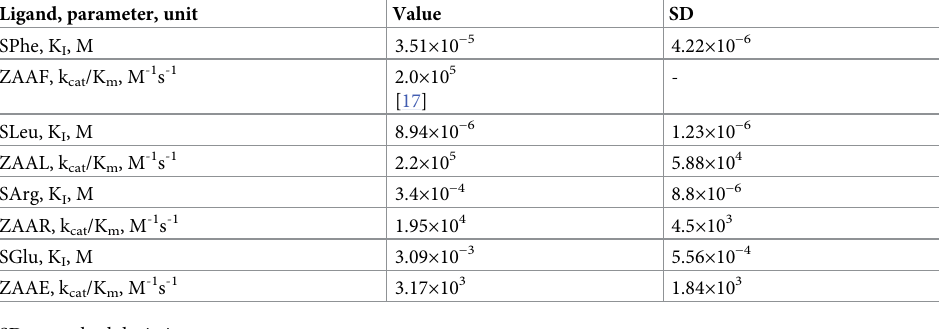
Table 4. Catalysis/inhibition parameters for